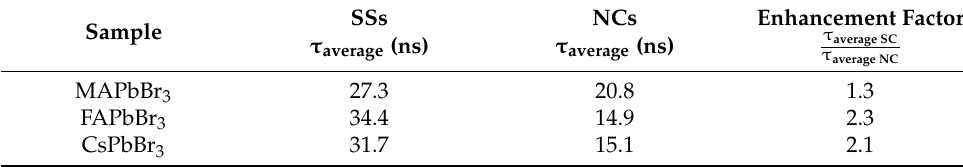
Figure 4. PL lifetime profiles of ( a ) ( i ) MAPbBr 3 , ( ii ) FAPbBr 3 , and ( iii ) CsPbBr 3 SSs and NCs. The excitation wavelength was 402 nm. The detection wavelength was 515 nm for MAPbBr 3 and CsPbBr 3 and 517 nm for FAPbBr 3 . The SEM images of ( b ) ( i ) MAPbBr 3 , ( ii ) FAPbBr 3 , and ( iii ) CsPbBr 3 SSs. And AFM height images of ( c ) ( i ) MAPbBr 3 , ( ii ) FAPbBr 3 , and ( iii ) CsPbBr 3 SSs. Table 1. Average fluorescence lifetime τ average